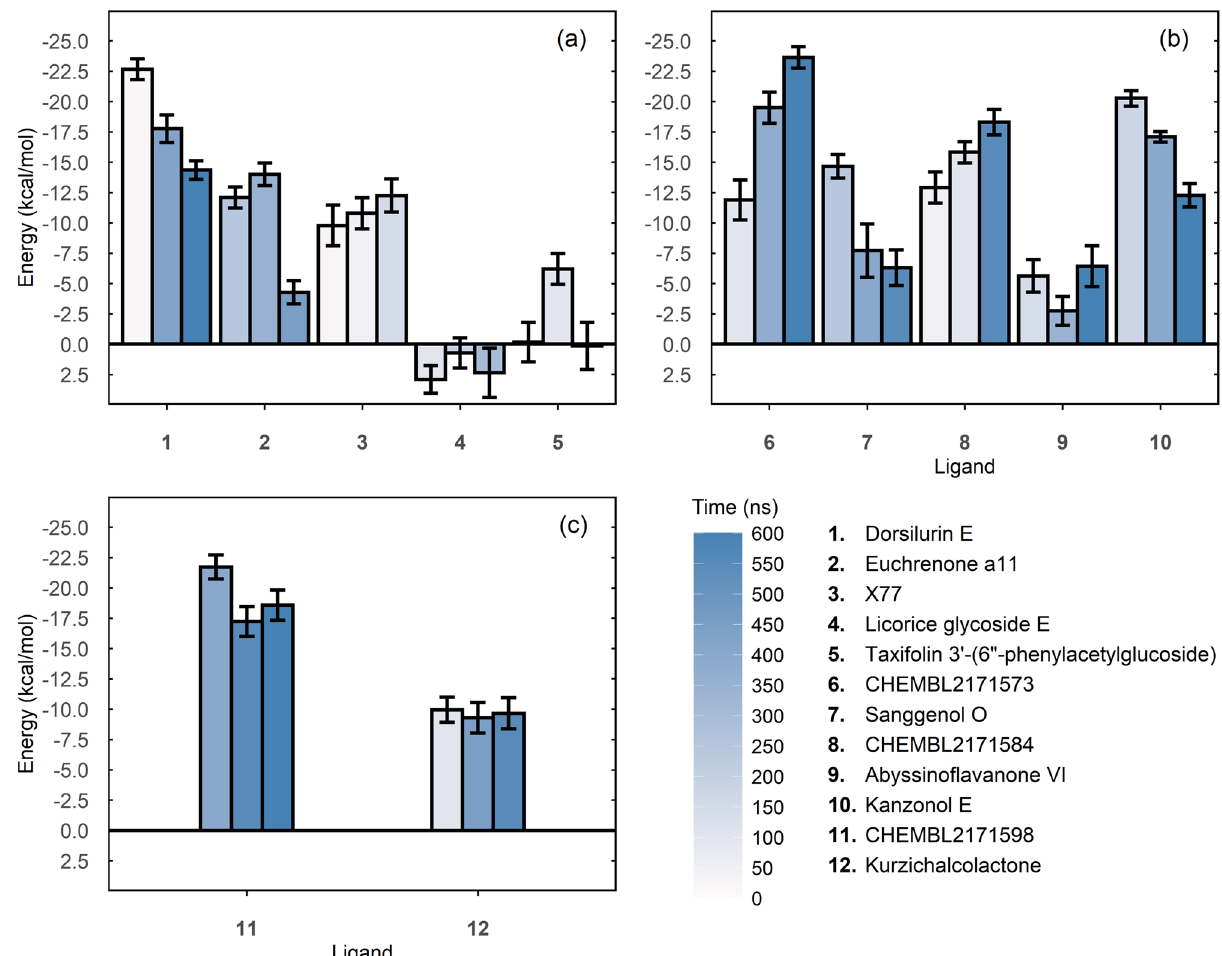
Figure 7. Mean and standard deviation values of binding energies calculated by the MMPBSA method. Mean binding energies are calculated from a N = 150 sample. Whiskers indicate standard deviations. Each N = 150 set was sampled by using a particular snapshot of the MD. Three snapshots were retrieved for each ligand. Darker blue filling indicates that snapshots have been taken from further along the holo MD. PBS: ( a ) SBS. Dorsilurin E had the most favourable energies, that started from − 22.66 kcal/mol (20 ns, s = 0.85) and gradually increased to − 4.34 (600 ns, s = 0.77). Its mean overall binding energy was − 8.25 kcal/mol. Positive control X77 had the second-best mean binding energy over time, with a peak at − 12.24 kcal/mol (150 ns, s = 1.37). Euchrenone a11 binding energies started from − 12.09 kcal/mol (250 ns, s = 0.88), decreased to − 14 kcal/mol (350 ns, s = 0.93) and then, closer to the unbinding event, stayed at − 4.27 kcal/mol (450 ns, s = 0.95). ( b ) DS. CHEMBL2171573 showed the lowest mean binding energy at − 18.33 kcal/mol, which decreased over time with a peak at − 23.63 kcal/mol (600 ns, s = 0.89). CHEMBL2171584 also showed decreasing mean binding energies over time that peaked at − 18.30 kcal/mol (550 ns, s = 1.04). Kanzonol E had an initial favourable value (− 20.26 kcal/ mol, 175 ns, s = 0.64) that increased with time (− 12.27 kcal/mol, 600 ns, s = 0.97). This ligand also showed the least standard deviation values. ( c ) CS. CHEMBL2171598 started with a mean binding energy (− 21.72 kcal/ mol, 400 ns, s = 0.98) that increased at 550 ns (− 17.23 kcal/mol, s = 1.22), only to decrease again at 600 ns (− 18.57 kcal/mol, s = 1.25). Overall, it showed the lowest mean binding energy at − 19.18 ISBS top 100 (Supplementary Dataset 3a,b). Remarkably, dorsilurin E and euchrenone a11 had more favourable docking scores, supporting both as possible inhibitors. During the screening process, sanggenol O and CHEMBL2171598 were within the top 30 in both the fast and the exhaustive-ranking stages (Supplementary Table 3). This consensus supports their inclusion as promising ligands. Consensus for dorsilurin E and euchrenone a11 could not be proven. It is important to remember that conformational search is higher in the exhaustive ranking. The reason why consensus was not found for SBS ligands might be because the rapid screening in Vina could not find the correct binding mode. This is further supported by the fact that binding modes for dorsilurin E and euchrenone a11 predicted during the fast and exhaustive ranking phases are different (data available upon request). The exhaustive-ranking protocol followed here was validated. It allowed for the reconstruction of three experi- mentally determined complexes in the lowest energy binding mode (Fig. 2). RMSDs were low considering that